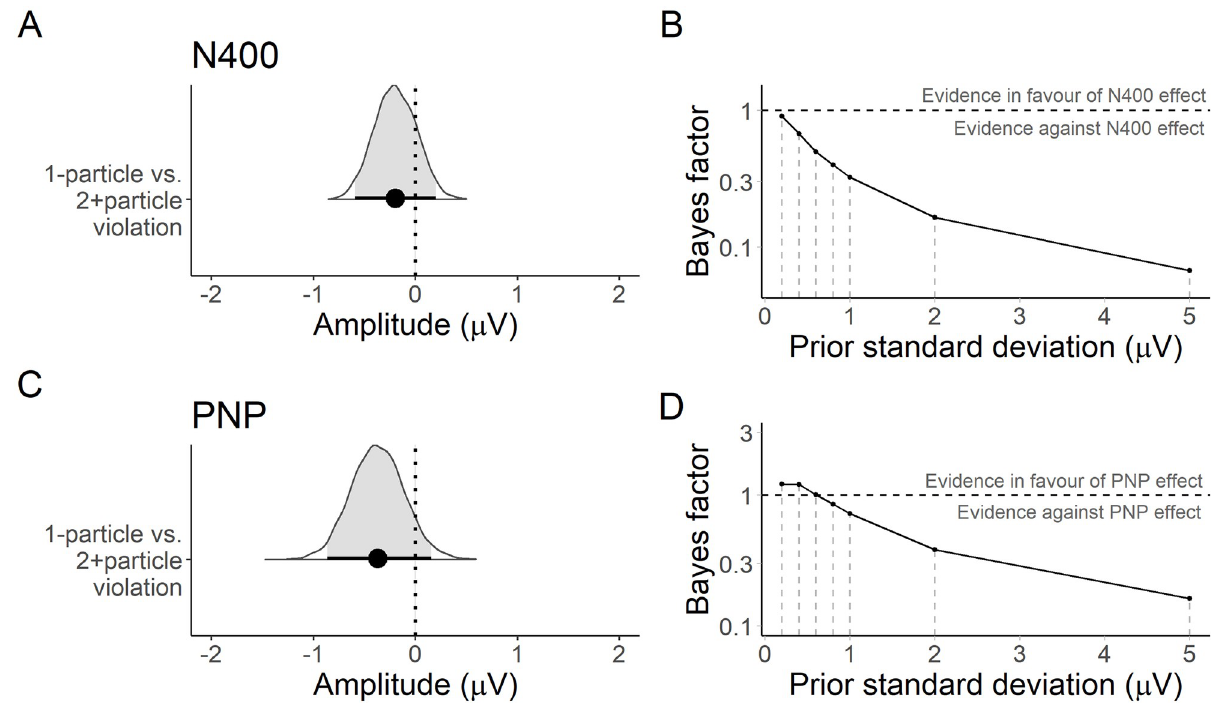
Fig 4. Experiment 2: Posterior estimates and Bayes factor analysis for the planned comparisons. A . Posterior distribution of the estimated difference in N400 amplitude associated with 1-particle condition vs. 2+particle violations. The mean and 95% credible interval are overlaid. B . Bayes factors computed under a range of priors comparing models with and without a predictor for the 1- vs. 2+particle condition manipulation. A Bayes factor of 1 indicates no evidence in favour of either model. Bayes factors below 1 indicate evidence against a difference in N400 amplitude associated with condition. C . Posterior distribution of the difference in PNP amplitude between the violation conditions. D . Bayes factors under a range of priors for the PNP effect.